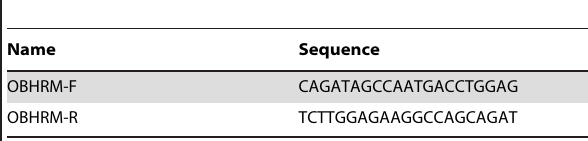
Table 1. Ob forward and reverse primer sequences for HRM.